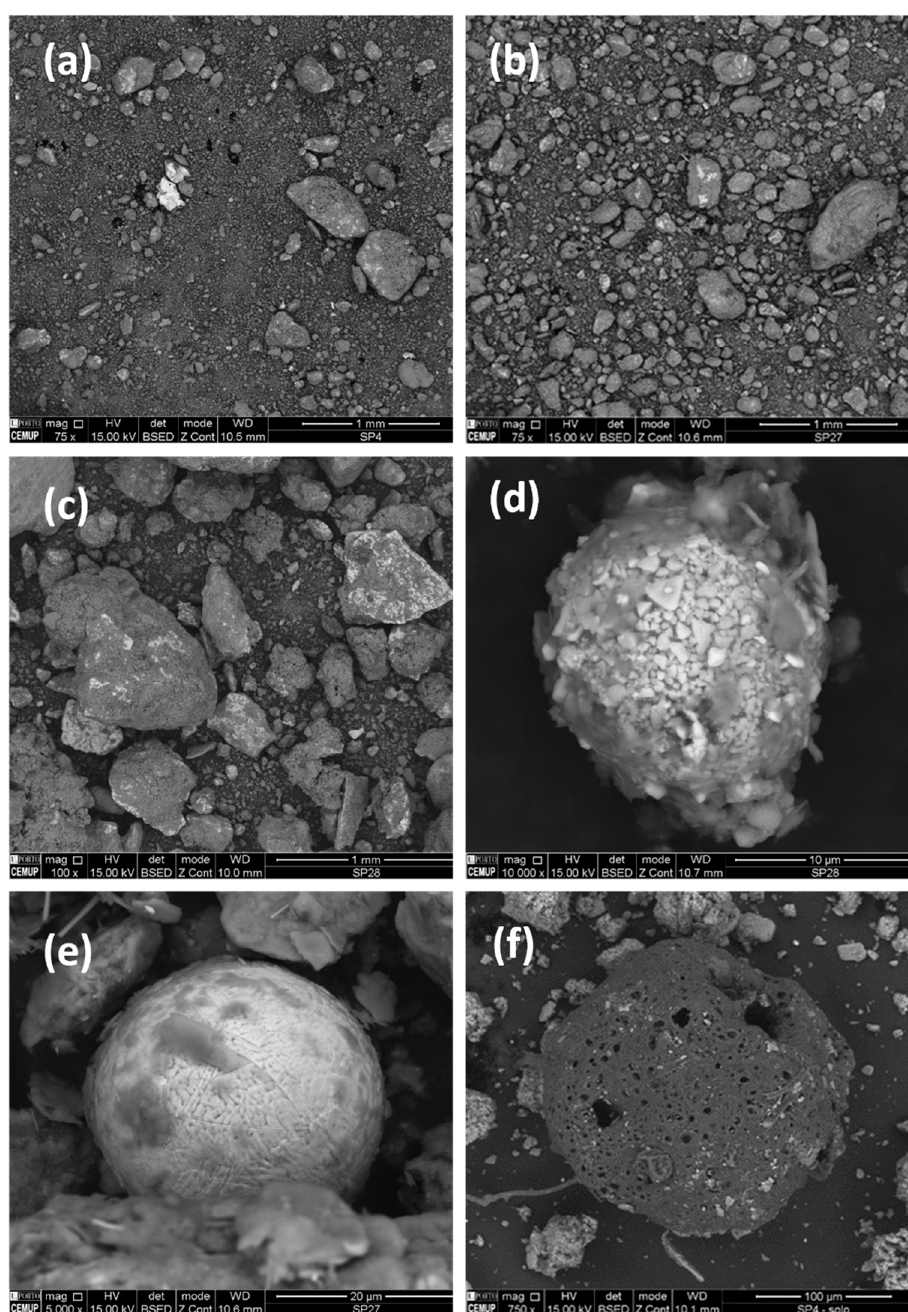
Figure 5. SEM images ( a – c ) ferrimagnetic fractions of soils with high magnetic susceptibility, ( d ) iron oxide spherule showing octahedral iron oxide crystallization, ( e ) iron oxides spherules with dendritic pattern with molten aluminium silicates on its surface, ( f ) rounded char porous particle.